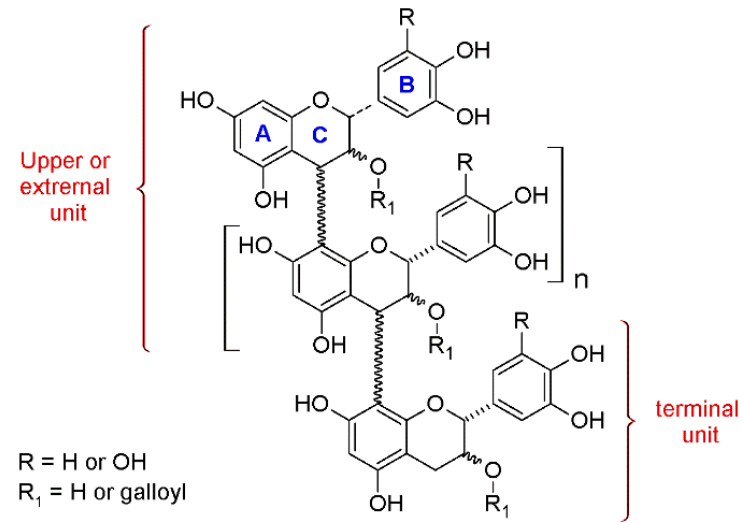
Figure 2. The units of the polymeric flavan-3-ols.